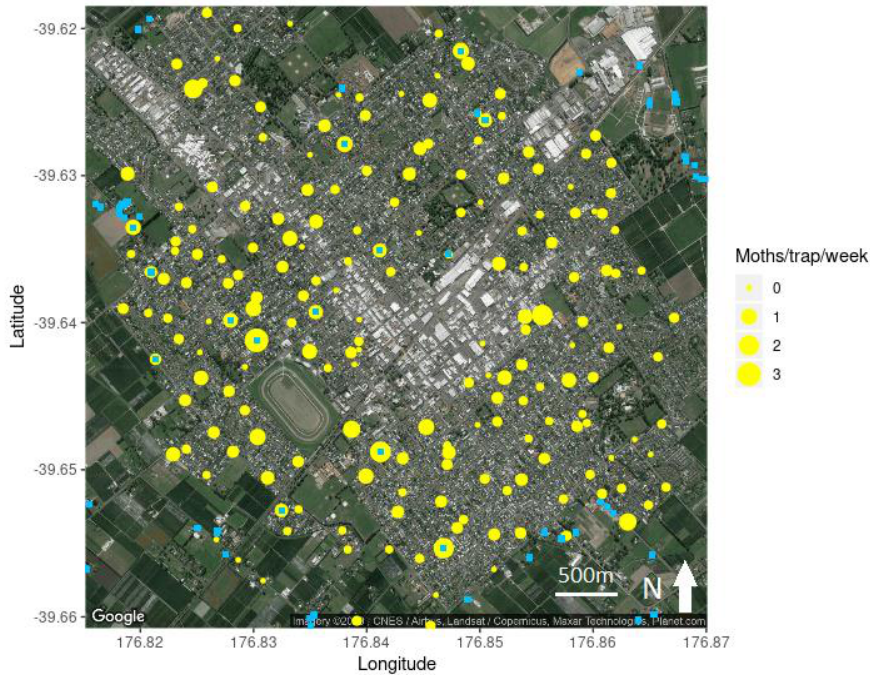
Figure 2. Distribution of the male codling moth ( Cydia pomonella ) catch rate across peri-urban Hastings alongside the location of known host trees (blue squares n = 351) and the location of the sex pheromone traps (yellow circles; n = 200). Map image courtesy Google Earth (4 June 2019).